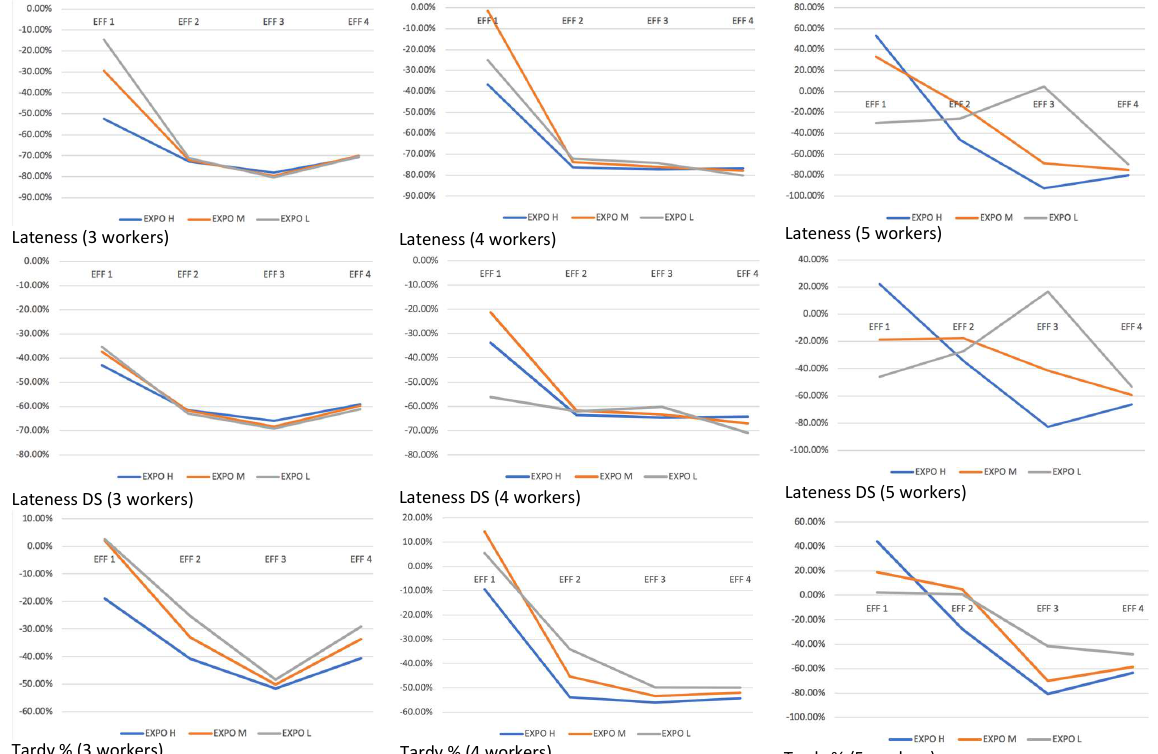
Fig. 1. Performance Assessment - Delivery